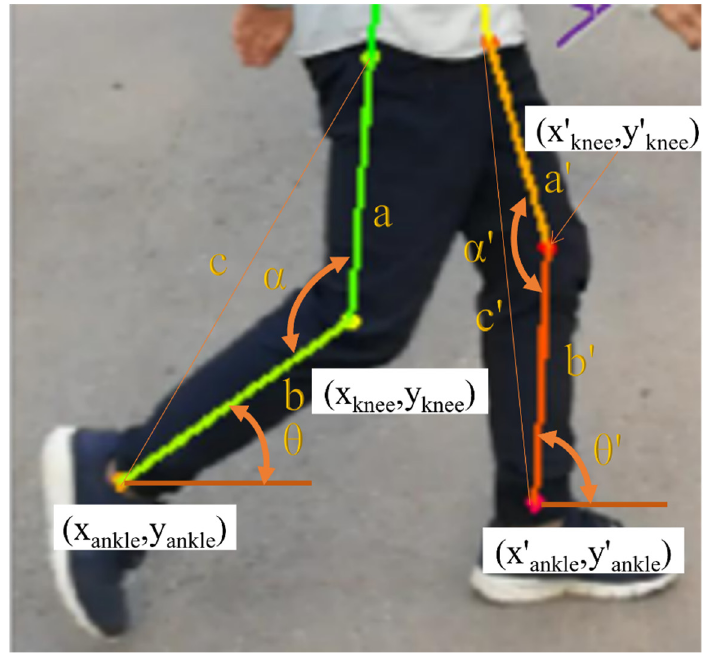
Figure 4. Movement Angle.